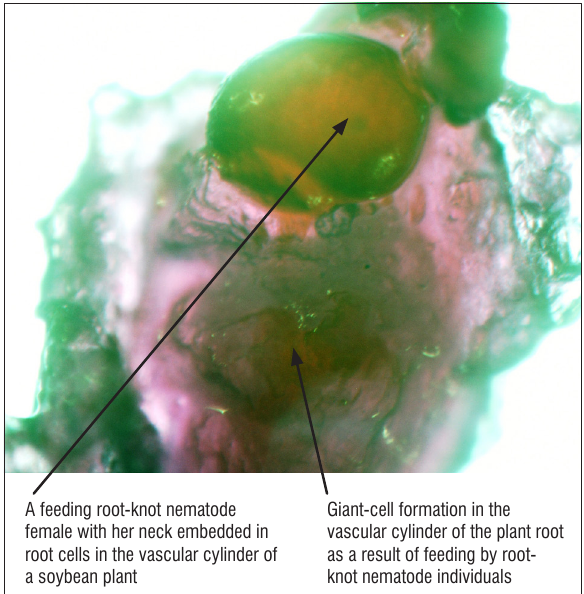
A feeding root-knot nematode female with her neck embedded in root cells in the vascular cylinder of a soybean plant